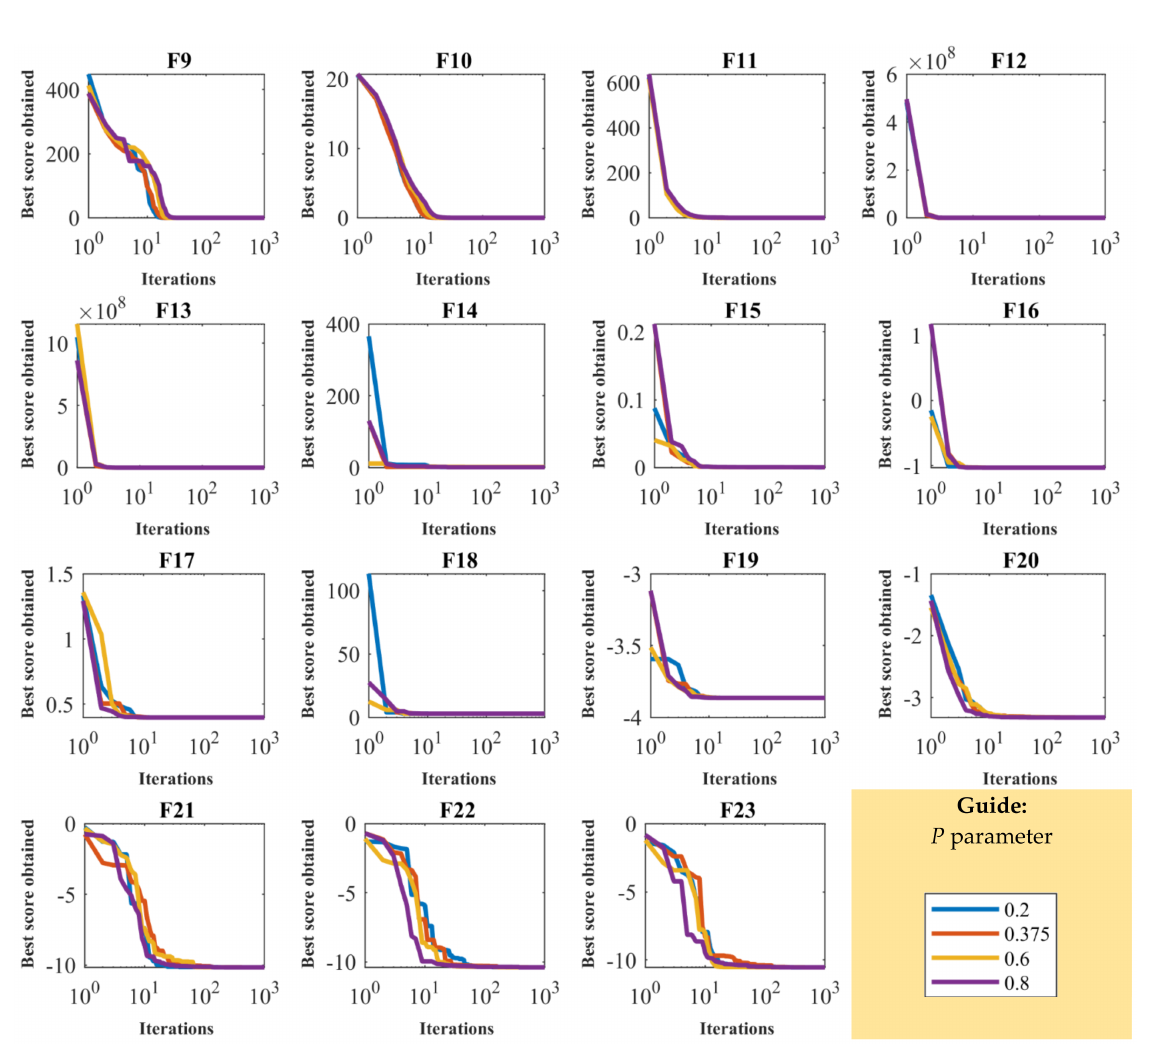
Figure 5. Sensitivity analysis of SLOA for P parameter. Table 8. Results of the algorithm sensitivity analysis to the number of population